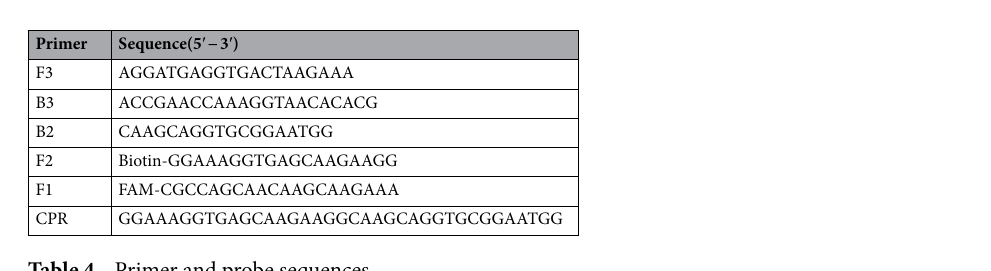
Figure 11. The specific positions and sequence of CPA primers and probes in the genome.